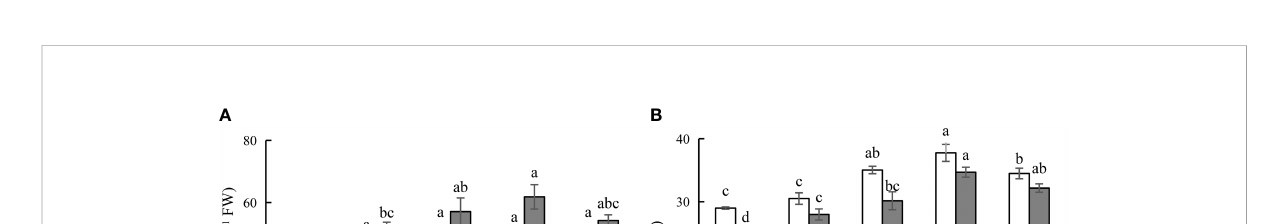
the Jingu 21> Zhangza 10 pattern. In the middle stage of grain fi lling, the sucrose content of Jingu 21 ranged from 0.97% – 1.15%, and that of Zhangza 10 ranged from 1.04% – 1.23% (Figure 5B). The Jingu 21 and Zhangza 10 cultivars had 28.99% – 37.75% and 24.81% – 34.62% starch contents, respectively. The sucrose/starch